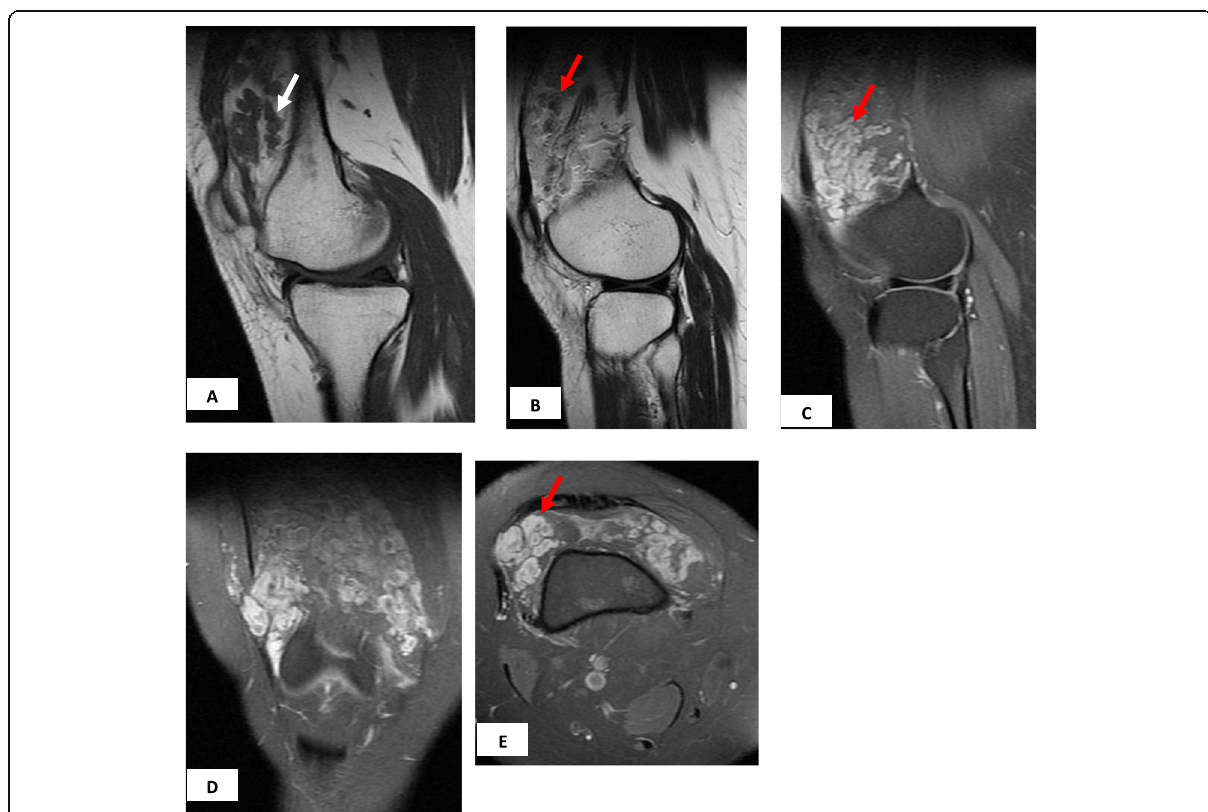
Fig. 4 Right knee synovial chondromatosis in 48-year-old male. Sagittal T1 ( a ), sagittal T2 ( b ), sagittal STIR ( c ), coronal STIR ( d ), and axial STIR ( e ) show non-mineralized equal size nodules showing low signal at T1 (white arrow), high at T2 and STIR (red